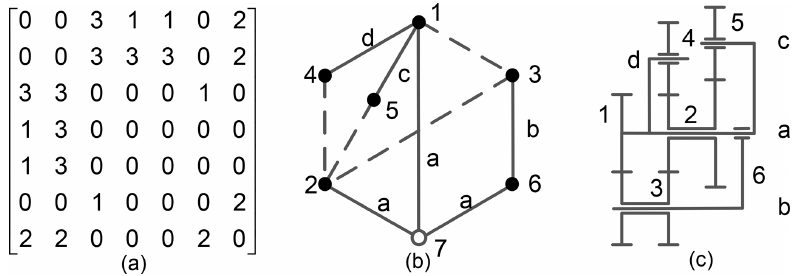
Figure 9. One more gear train. (a) The adjacency matrix, (b) d graph, and (c) mechanism diagram.